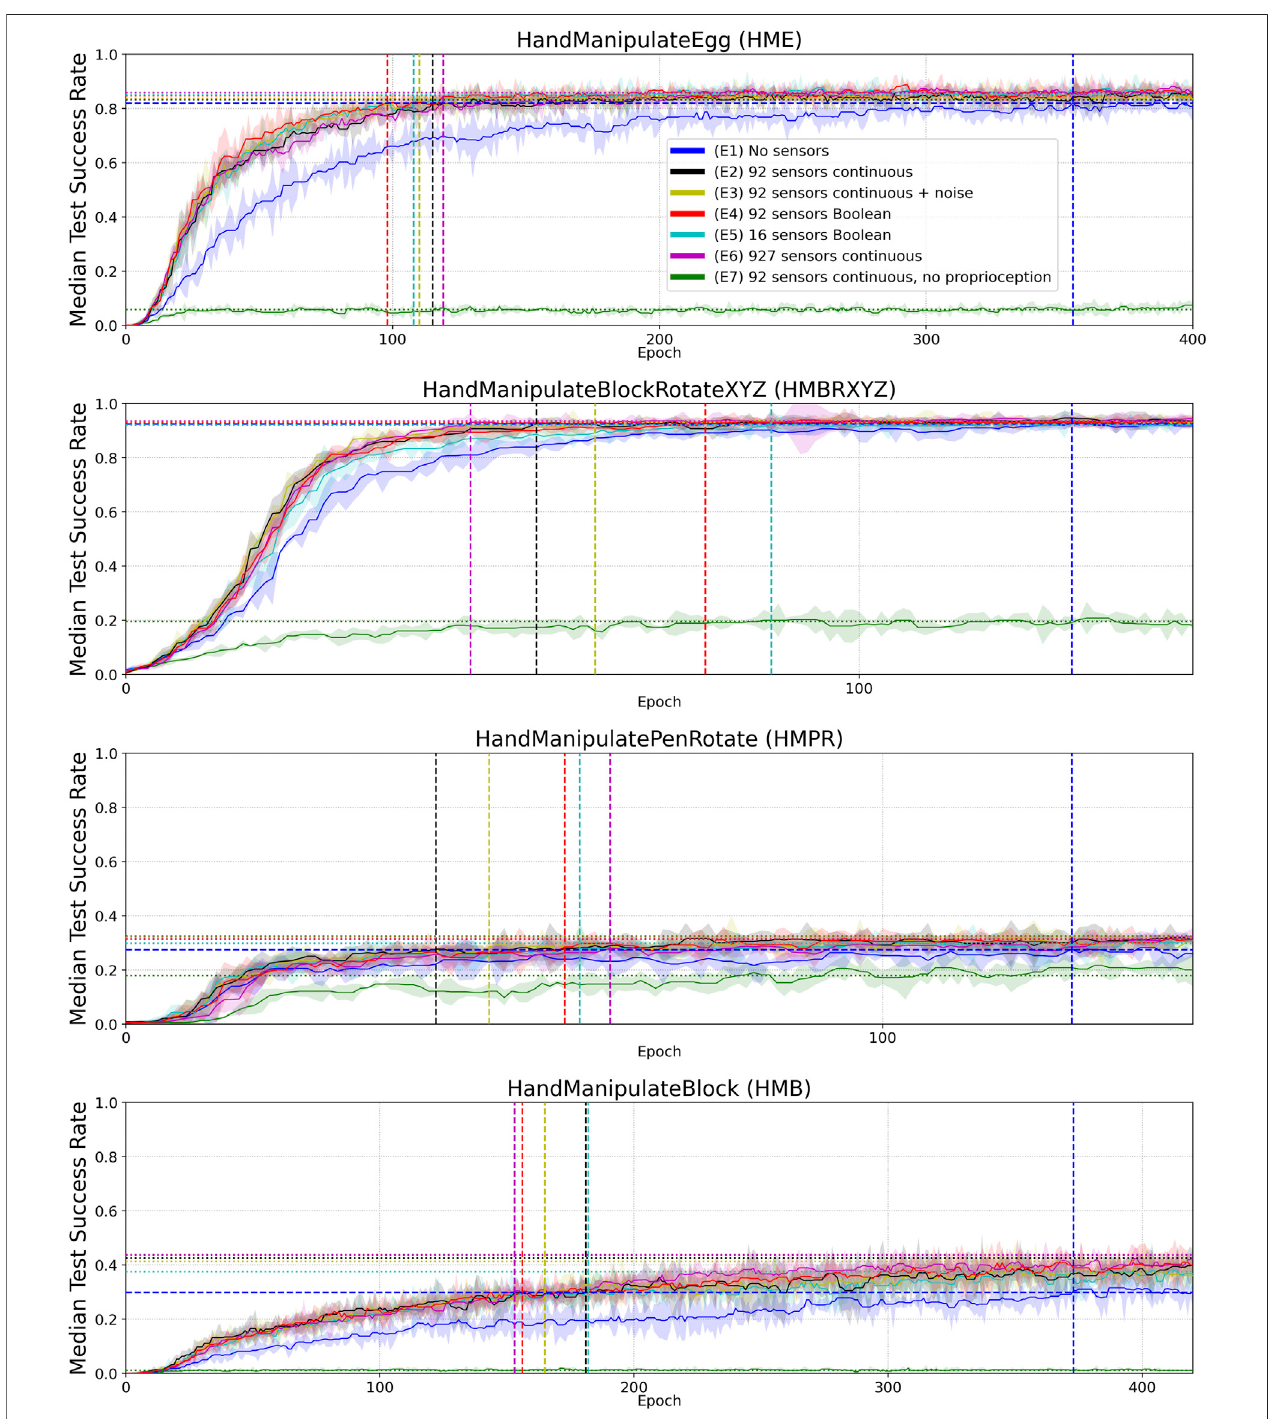
FIGURE 4 | Median Success Rate curves (vertical axes) vs. training epochs (horizontal axes) for tasks HME, HMBRXYZ, HMPR, HMB and experiments E1 – E7 (colored curves – see HME fi gure legend). See Figure A1 in Appendix for the full convergence tails. Each curve shows the median success rate across fi ve different trainingtrialswithadifferentrandomseed.Thesuccessratevalueineachtrainingtrialisthemeanof10testsaftereachtrainingepoch.Themediansmoothingwindowof plotted curves is equal to fi ve epochs. Shaded areas represent the interquartile range. Horizontal dotted lines highlight the success-rate-convergence level of corresponding (color) curves ( Table 4 ). The blue horizontal dashed line highlights the success-rate-convergence level of learning without touch sensors (No sensors) ( Table 5 ). Vertical dashed lines (blue, black, yellow, red, and green) highlight the intersection of corresponding curves (color) with the blue dashed line ( Table 5 ).